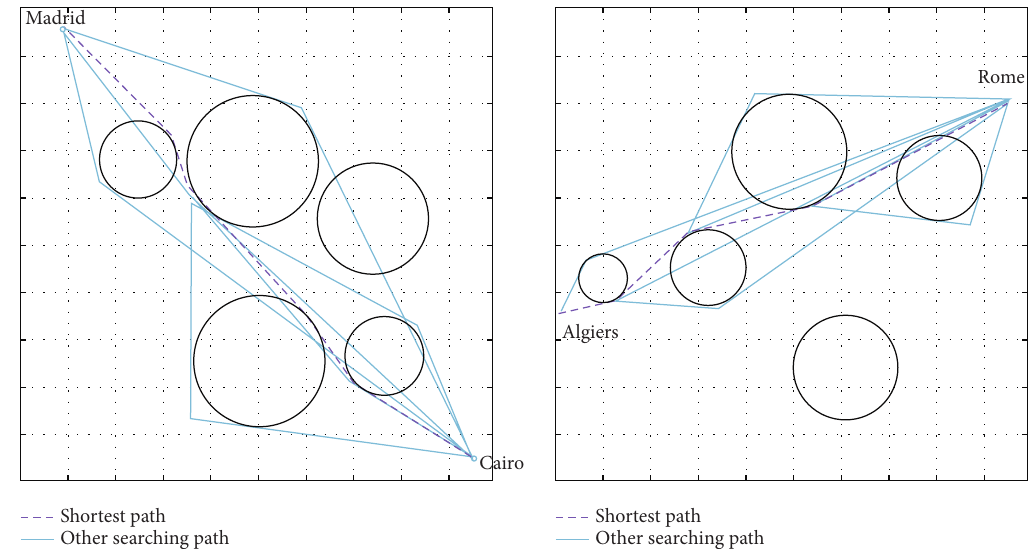
Figure 13: Searching process of the improved A-star algorithm.